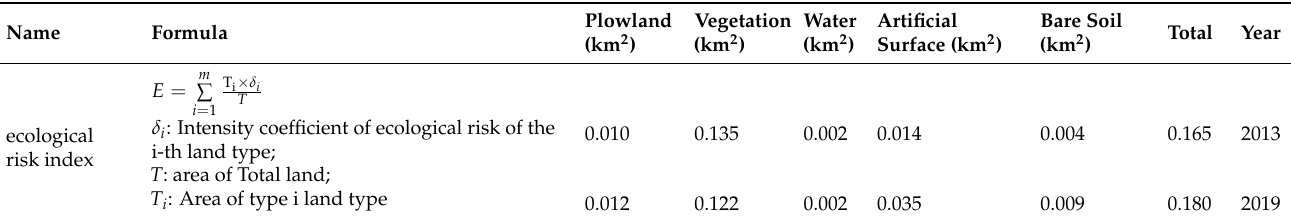
Table 8. The ecological risk index of